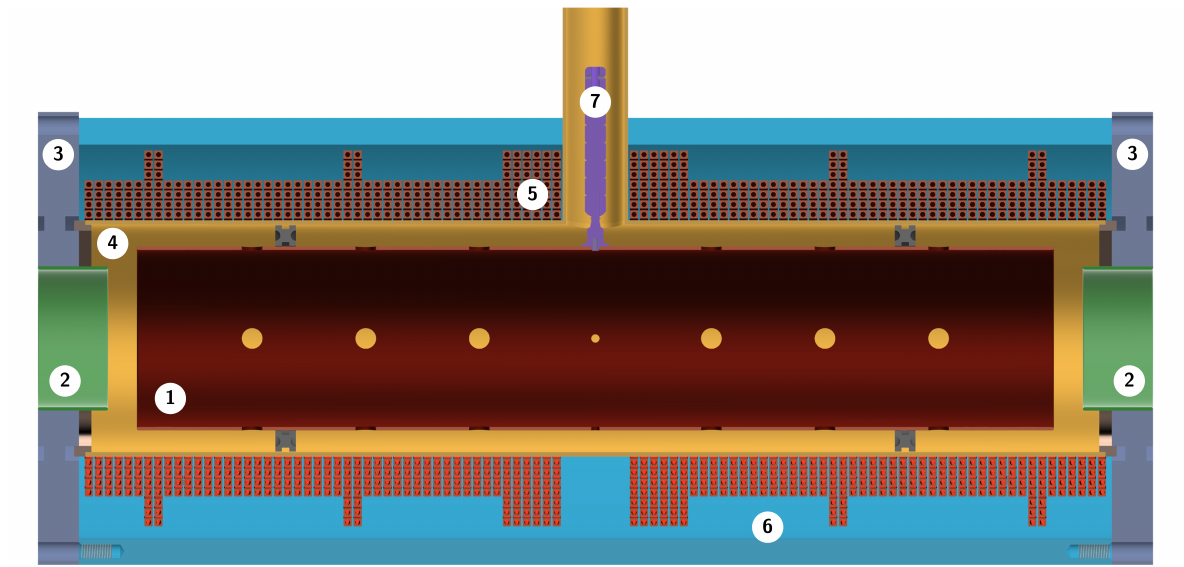
Figure 1. Internal structure of the IC Gabor lens viewed in longitudinal cross-section. The main components are: 1-central anode, 2-end electrodes, 3-end flanges, 4-vacuum tube, 5-pancake coils, 6-outer tube, 7-high-voltage